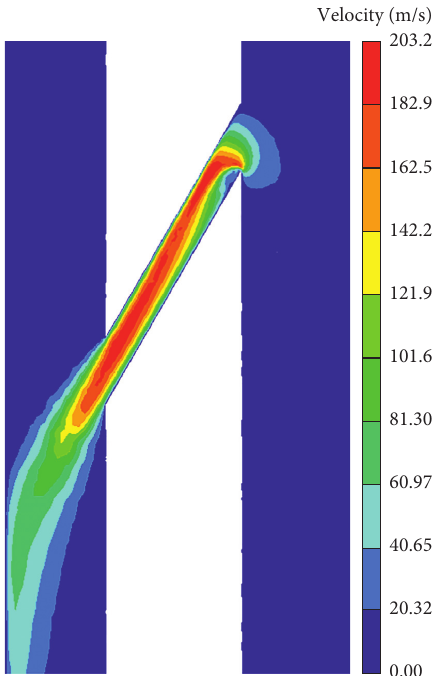
Figure 6: Backward jet velocity cloud diagram of the jet